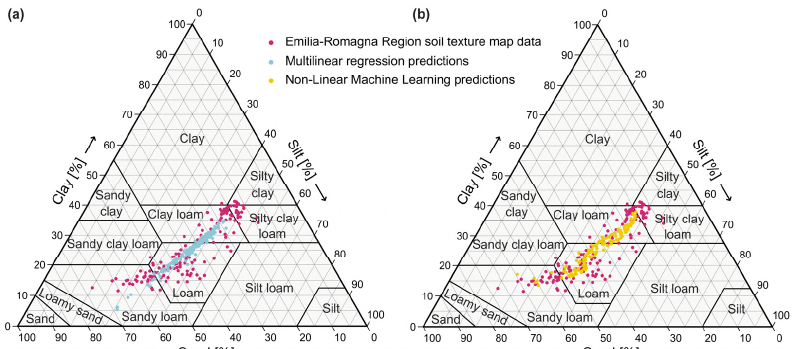
Figure 5. USDA soil textural triangle with data extracted from the RER map (145 data, testing dataset)